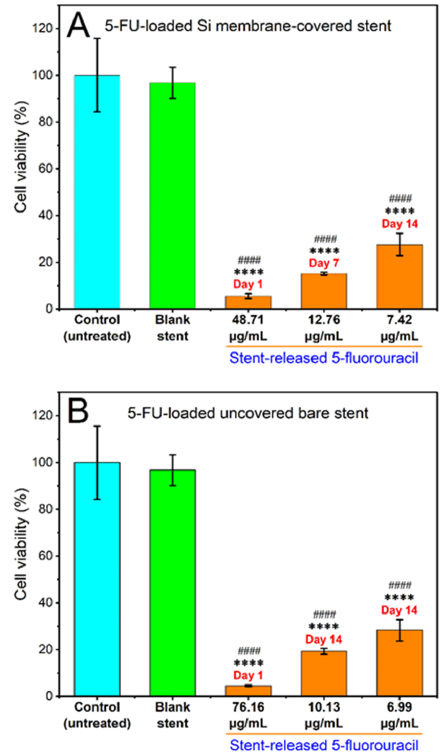
Figure 9. Effects of various concentrations of 5FU released over day 1, 7 or 14 from the ( A ) Si-PU 5FU -PEVA and ( B ) B-PU 5FU -PEVA stent sections on the viability of HCT-116 human colon cancer cells treated for 72 h, determined by MTT assay. Results from at least three replicate measurements are given as mean ± SD. p -values were calculated using one-way analysis of variance (ANOVA). **** p < 0.0001 and #### p < 0.0001 compared to the untreated control and blank (drug-free) stent sections, respectively. The cell viability for drug-free blank sections was ~ 97% compared to the non-treated (media) controls, which excludes the possibility of cytotoxicity from the PU-PEVA stent platform. For both 5FU-loaded stent types there was a clear trend of concentration-de- pendent reduction of cell viability following 72 h of exposure, with statistically significant differences observed between the stent-released 5FU concentrations and the non-treated (media) or drug-free (blank) controls (Figure 9). In comparison to pure 5FU drug concen- trations, all stent-released 5FU concentrations showed similar inhibition of cell prolifera- tion (SI, Figure S12). Since the stent-released 5FU concentrations were not exactly the same as the pure 5FU drug concentrations (positive control) used in constructing the 5FU dose- response curve, no statistical significance was determined between the cell viability (%) data of the stent-released 5FU and pure 5FU drug. However, these results demonstrate